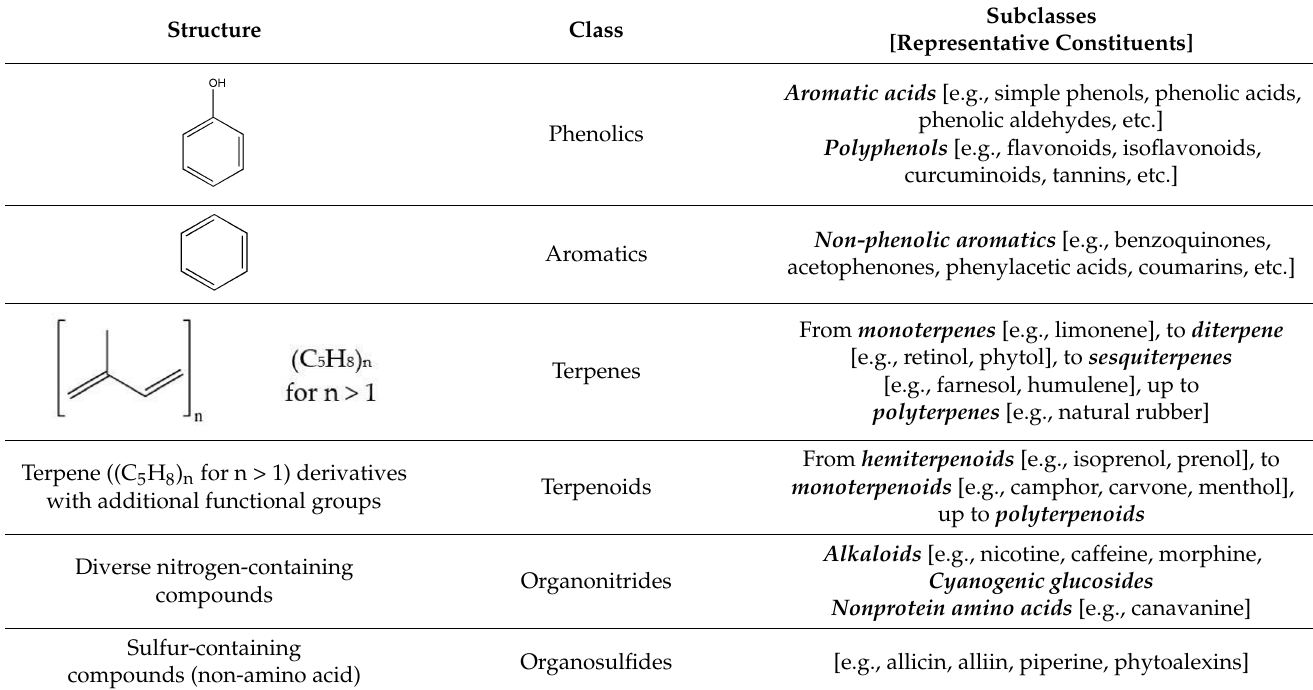
Table 1. Classification of the phytochemicals recognized in the literature survey and used in the meta-analyses.